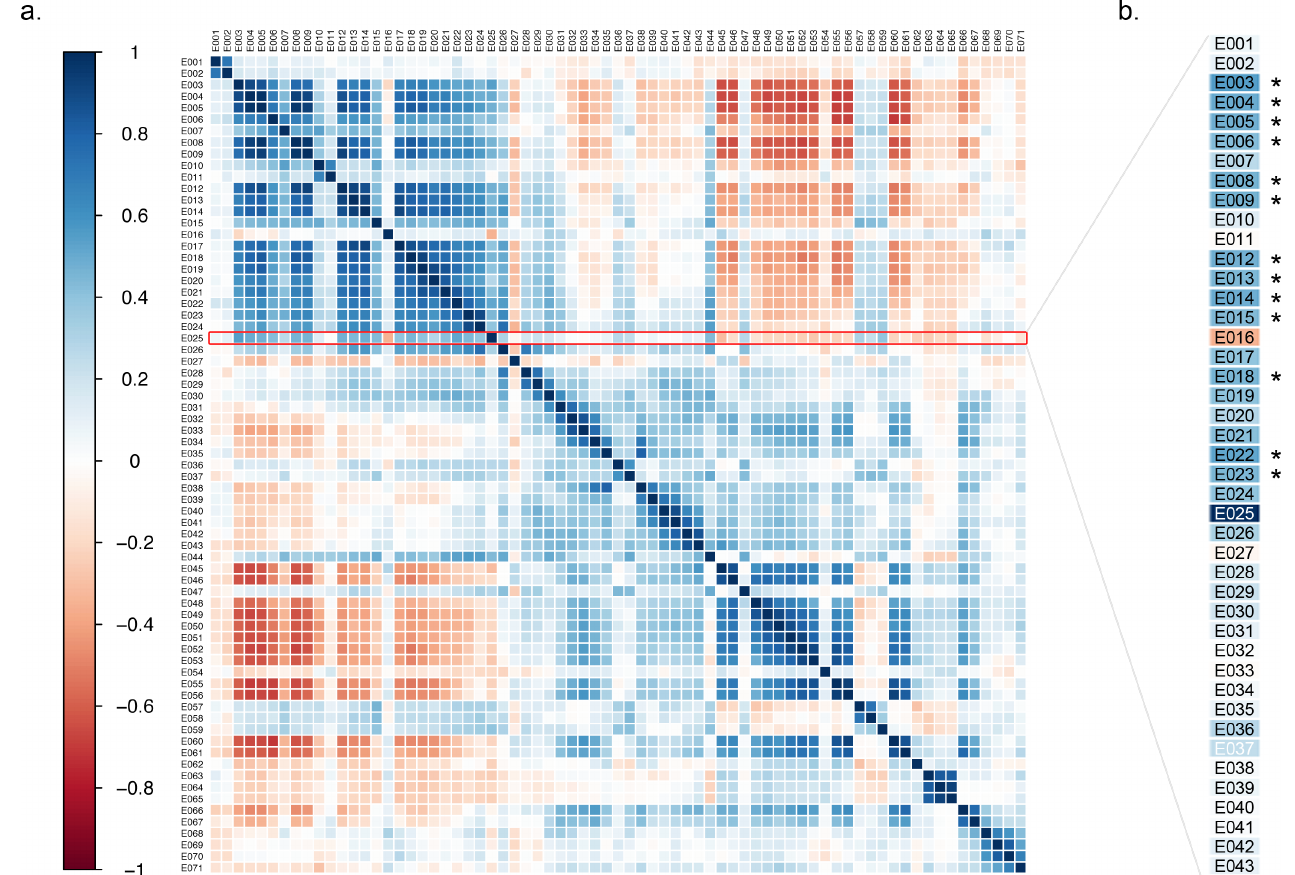
Fig 2. GAK Gencode 3 ’ exons are significantly correlated with GAK Gencode exon 25 by Spearman correlation. (A) The numbers along the color scale represent the r-values for each correlation. Positive correlations are represented by blue shades, while negative correlations are represented by red shades. The 3 ’ end of the gene corresponds to exon one (E001 in the upper left-hand corner), while the 5 ’ end of the gene corresponds to E071. (B) Exons significantly associated with GAK25 (using an adjusted α -level of 1.6x10 -4 ) are starred and are found predominantly in 3 ’ region. Exons 1 – 44 are shown, as the exons contained in this range were the only ones significantly correlated after correction for multiple